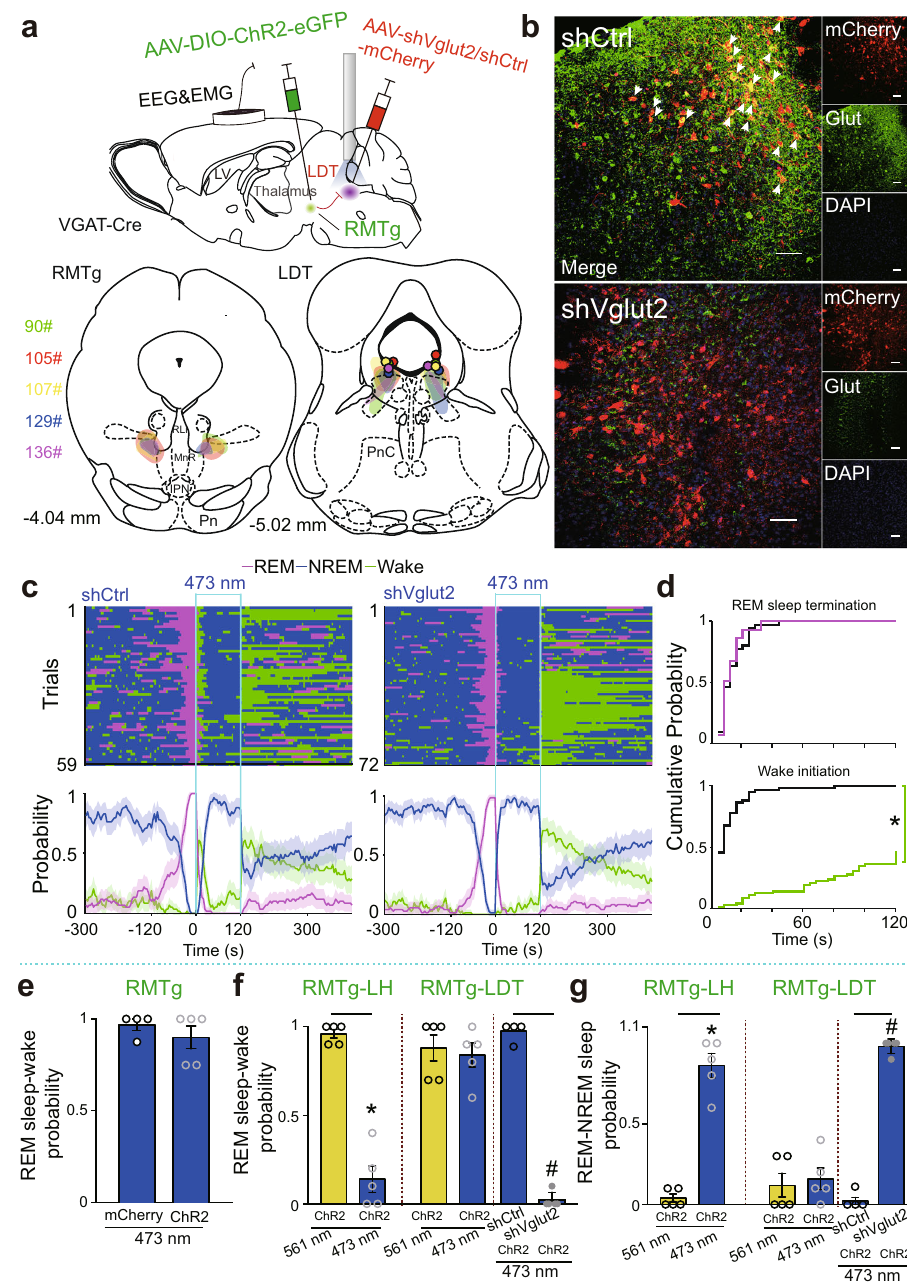
Fig. 7 | Causal evidence for transient arousal from REM sleep by activation of the RMTg GABA -LDT circuit. a Schematic diagram of the experimental protocol (top). The coronal section shows the superimposed virus-injected area (bottom, left: RMTg; right: LDT) and the tips of optical fi bers in the LDT (bottom, right). b Representative photographs of coronal sections containing the LDT from a control (top) and a knockdown (bottom) VGAT-Cre mouse. The images show mCherry-expressing neurons (red), glutamate (Glut)-expressing neurons (green, but not the green ChR2-expressing RMTg GABAergic nerve endings), merged neurons (yellow) pointedto by arrows with Glut and mCherry, and 4 ′ ,6-diamidino- 2-phenylindole(DAPI, blue) staining. Scalebar,50 μ m. c Sleep – wake state changes (top) and probability of brain state transitions (bottom) after photostimulation of RMTgGABAergicaxonendingsintheLDTduringREMsleeplastingnolessthan16s beforelaseroninalltrialsfrommiceintheshCtrl(left)andshVglut2(right)groups. Shading indicates 95% con fi dence intervals. d During 120s laser stimulation of the